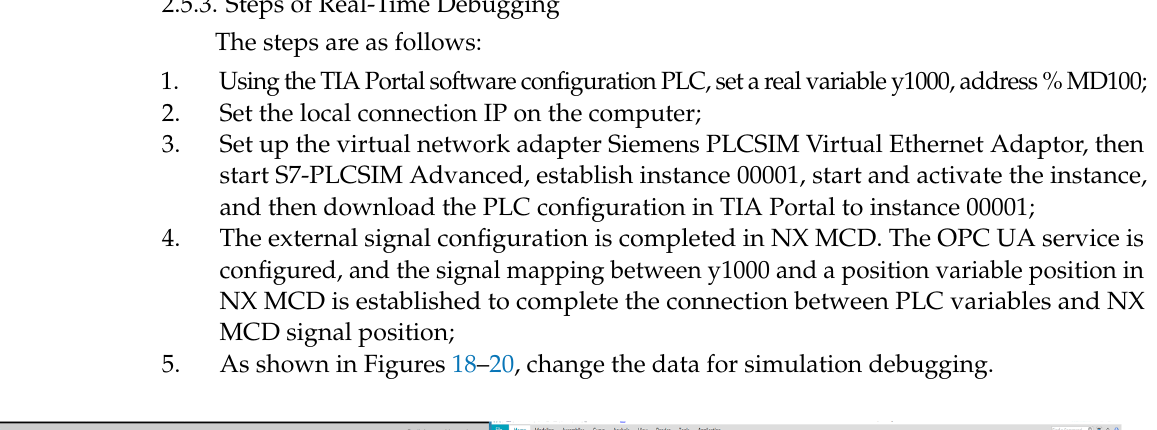
Figure 17. Signal mapping of the first part of the processing area.